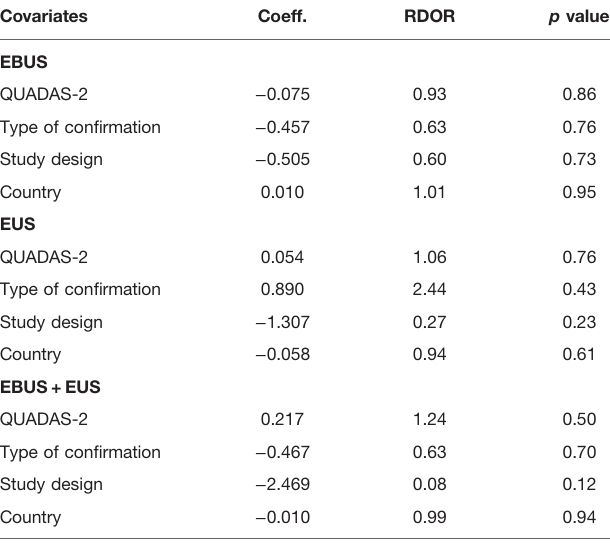
TABLE 3 | Weighted meta-regression of the effects of methodologic al characteristics, study design, country, and type of con fi rmation. Covariates